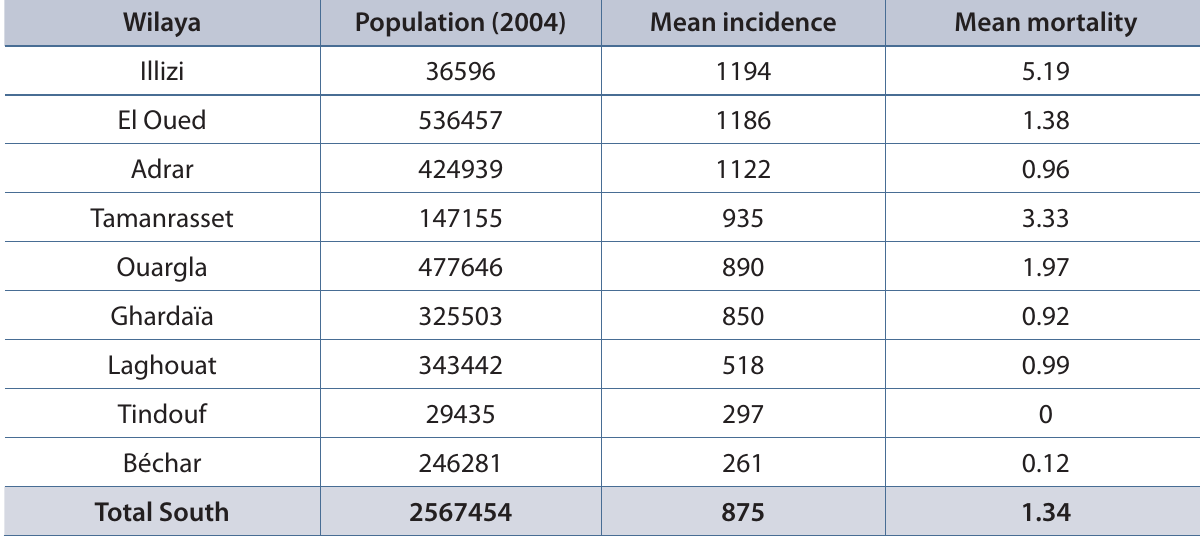
Table 4. Incidence and mortality in the South (2001-2010) Wilaya Population